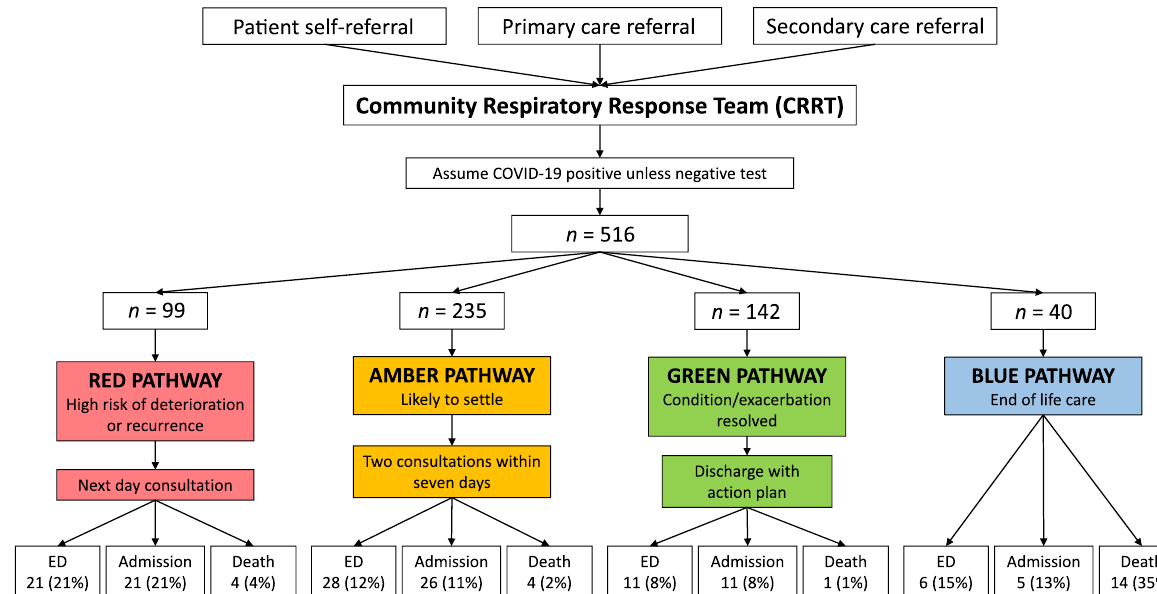
Fig. 1 CRRT triage pathway and patient outcomes by pathway. Outcomes of patients referred to the CRRT. Percentage values refer to proportions of individual